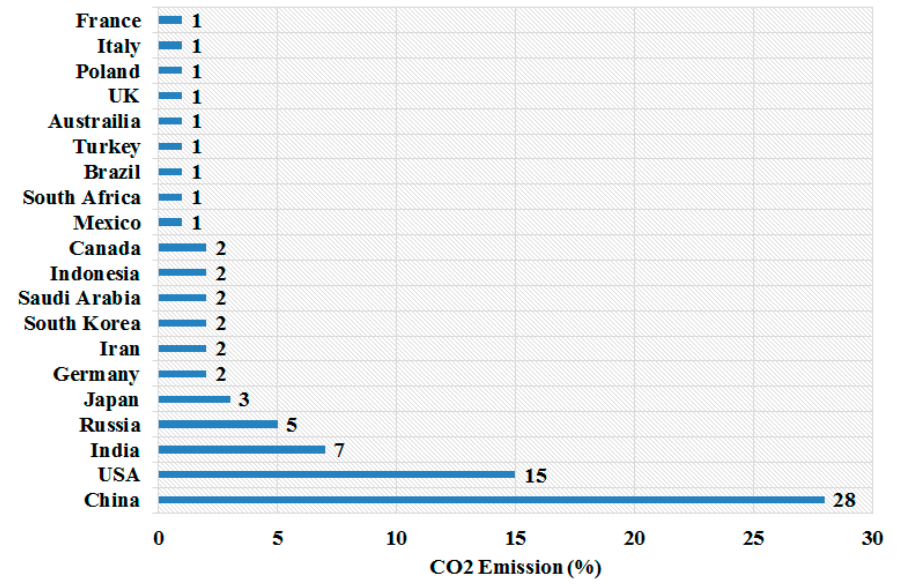
Figure 3. CO 2 emission in billion metric tons (as on 27 October 2020) by the foremost countries in world in the year 2020 [14].